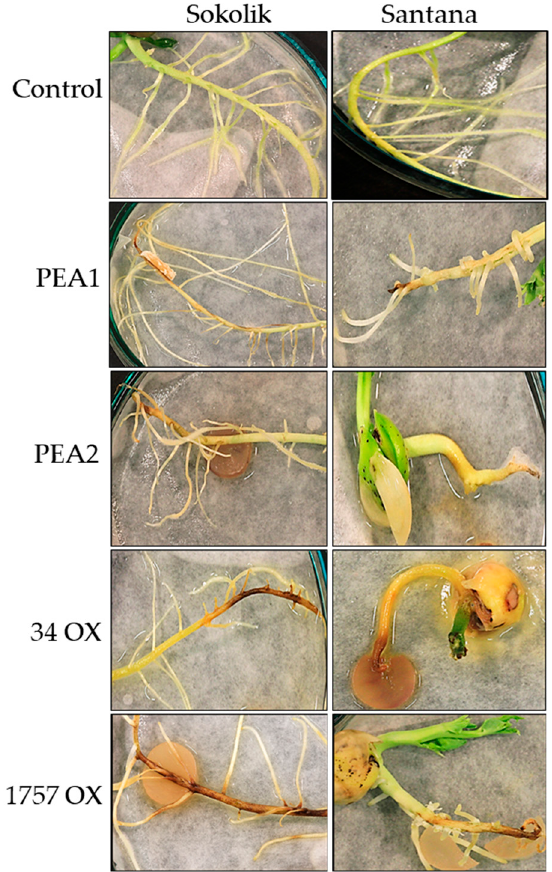
Figure 1. Roots of control plants and seedlings infected with F. proliferatum (PEA1, PEA2) and F. oxysporum (34 OX, 1757 OX) from Sokolik and Santana after 7 days of infection .